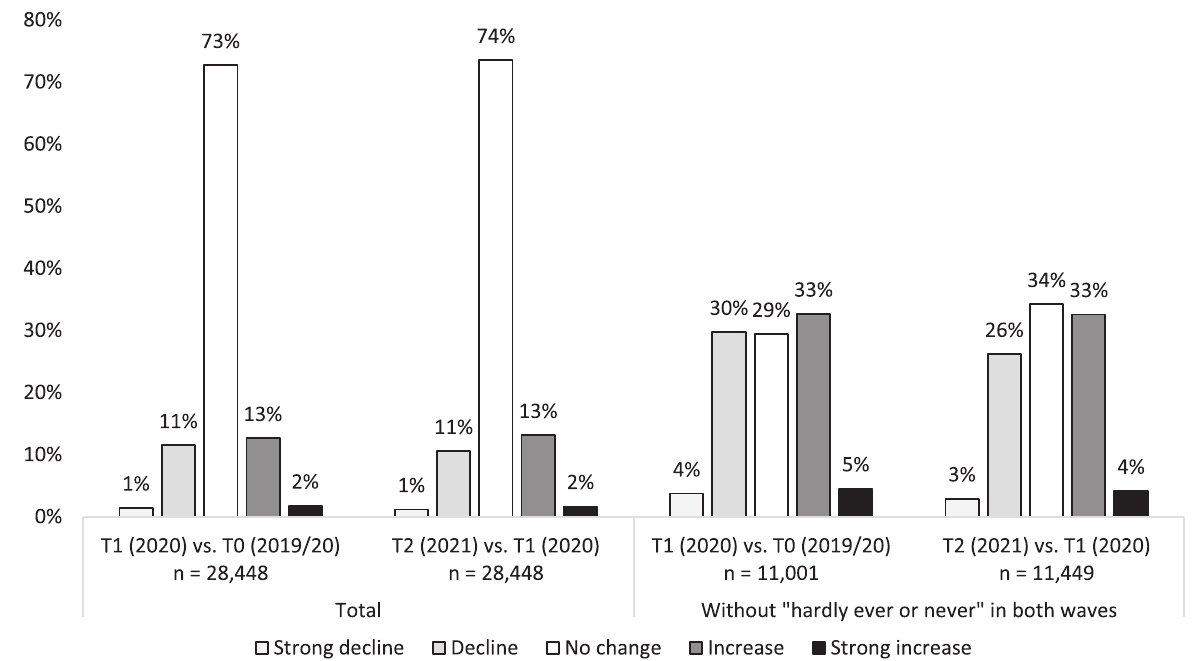
Figure 2. Changes in loneliness during the pandemic. Source: Based on SHARE waves 8 and 9, release 8.0.0. than or just as lonely as one year before. However, the comparison also indicates that the proportion of respon‐ dents who experienced a decline in loneliness was sig‐ nificantly lower at T2 compared with T1 (Wilcoxon test with p =